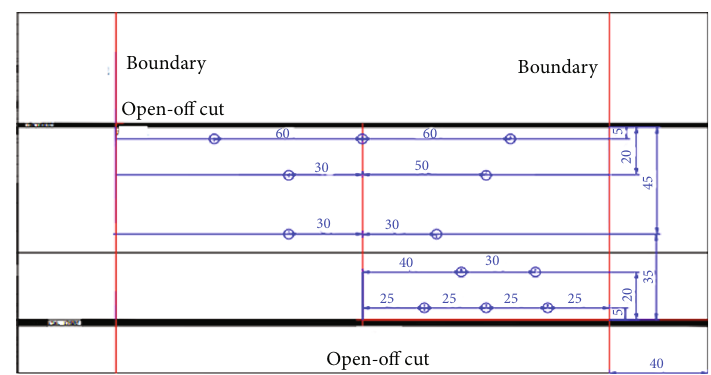
Figure 7: Arrangement of measuring points.